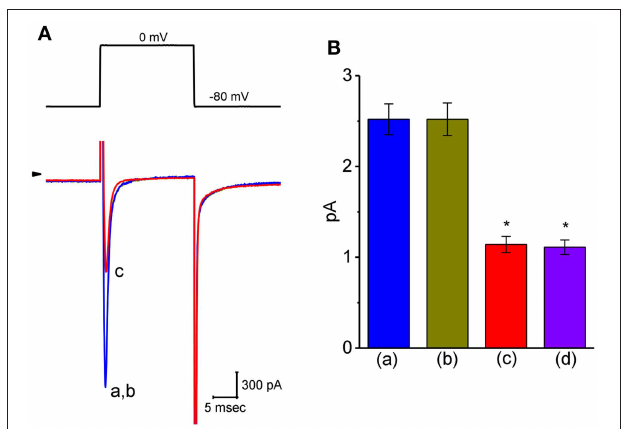
FIGURE 8 | Effect of VP on voltage-gated Na + current ( I Na ) in GH 3 cells. The whole-cell current recordings made in this set of experiments were conducted in cells bathed in Ca 2 + -free Tyrode’s solution containing 10mM TEA and 0.5mM CdCl 2 , and the recording pipette was filled with Cs + -containing solution. (A) Original I Na traces elicited by rapid membrane depolarization. The voltage protocol used is indicated in the upper part and arrowhead refers to the zero-current level. a: control; b: 3 µ M VP; c: 3 µ M VP plus 3 µ M A-803467. (B) Summary bar graph of the effect of VP, VP plus A-803467, and VP plus A-887826 on the peak amplitude of I Na (mean ± SEM; n = 11 for each bar). The peak I Na amplitude was measured at the beginning of short depolarizing pulse from a holding potential of − 80mV. *Significantly different from control ( P <